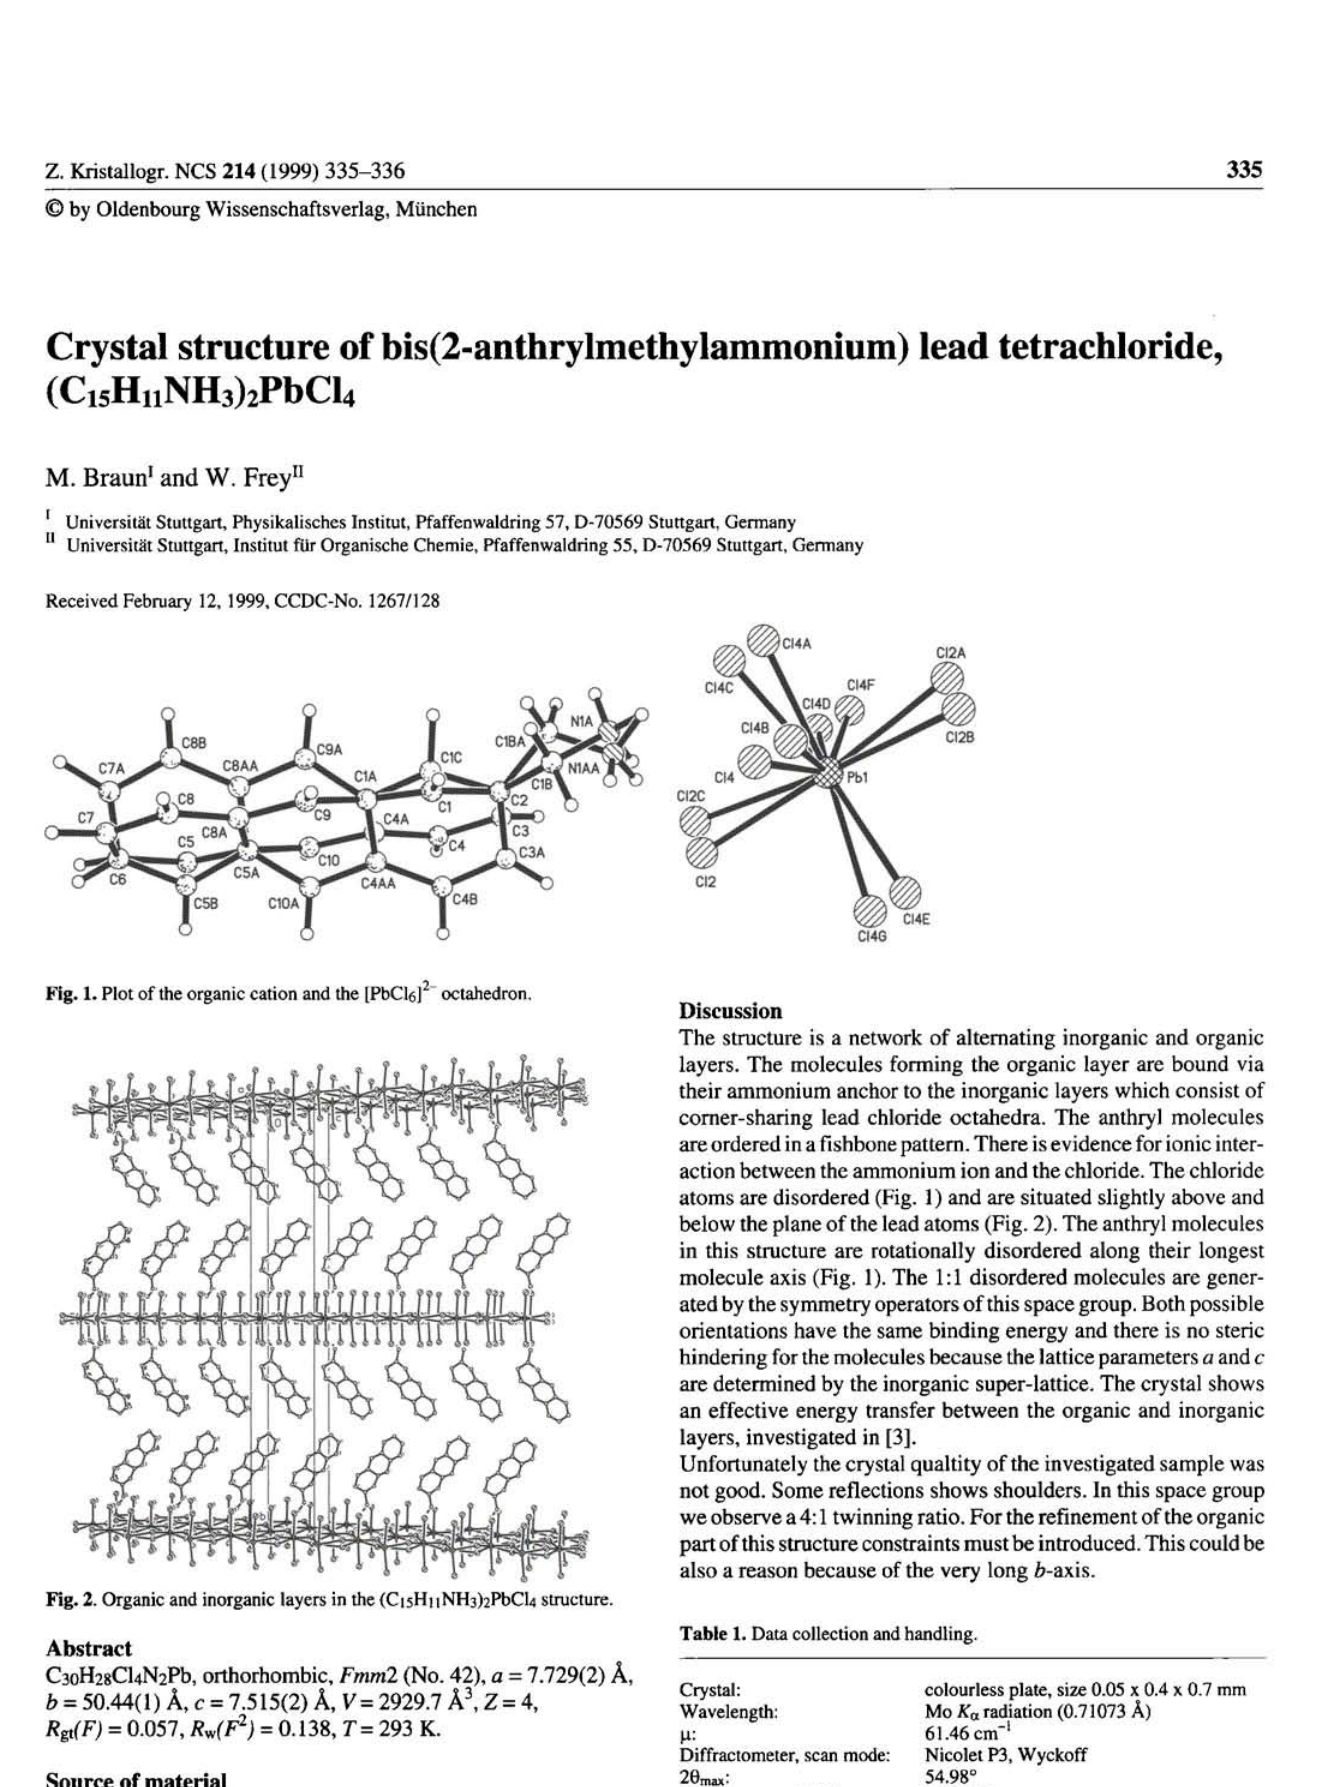
Fig. 2. Organic and inorganic layers in the (CisHnNHs^PbCU